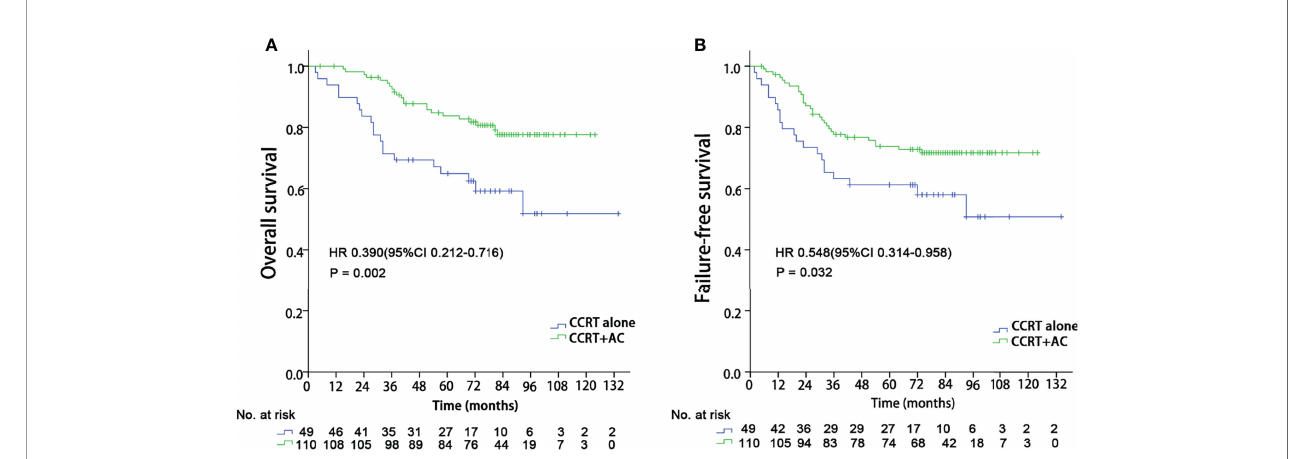
FIGURE 6 | Kaplan – Meier survival curves in the CCRT + AC and CCRT alone arms for patients in the RPA 4 group. CCRT, Concurrent chemoradiotherapy; AC, Adjuvant chemotherapy; RPA, Recursive partitioning analysis; (A) Overall survival; (B) Failure-free